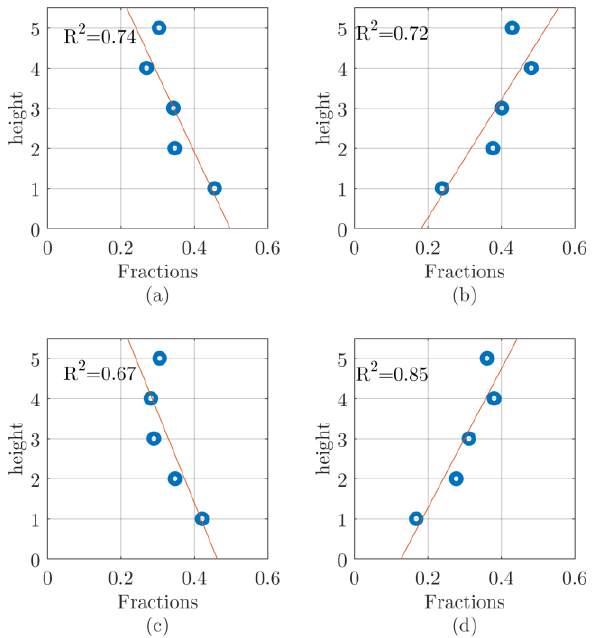
Figure 9. 2D plot of the EMs’ fraction statistic features vs. the cubes’ height in each pattern. (a) and (b), fraction of the cube and shadow EMs, respectively from zenith view image. (c) and (d), the mean fraction of the cube and shadow EMs, respectively. The coefficient of determination between the statistical feature and the cube’s height presented as R 2